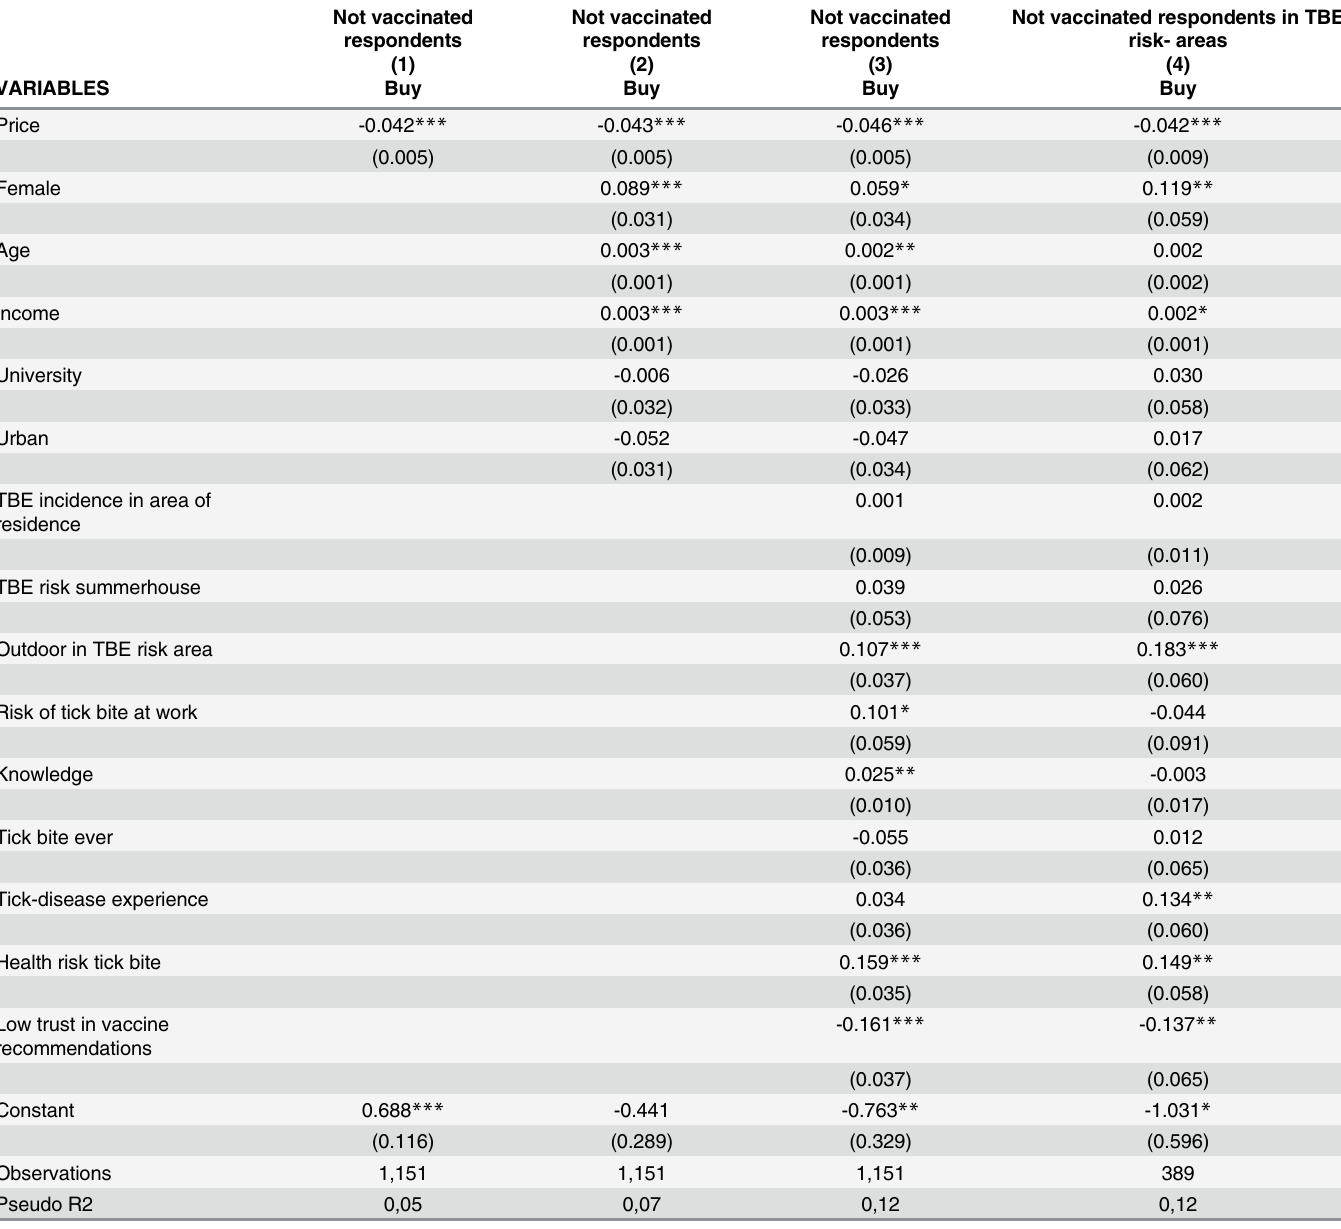
Table 2. Determinants of willingness to pay for TBE vaccination; Marginal probabilities after logit evaluated at sample means a .